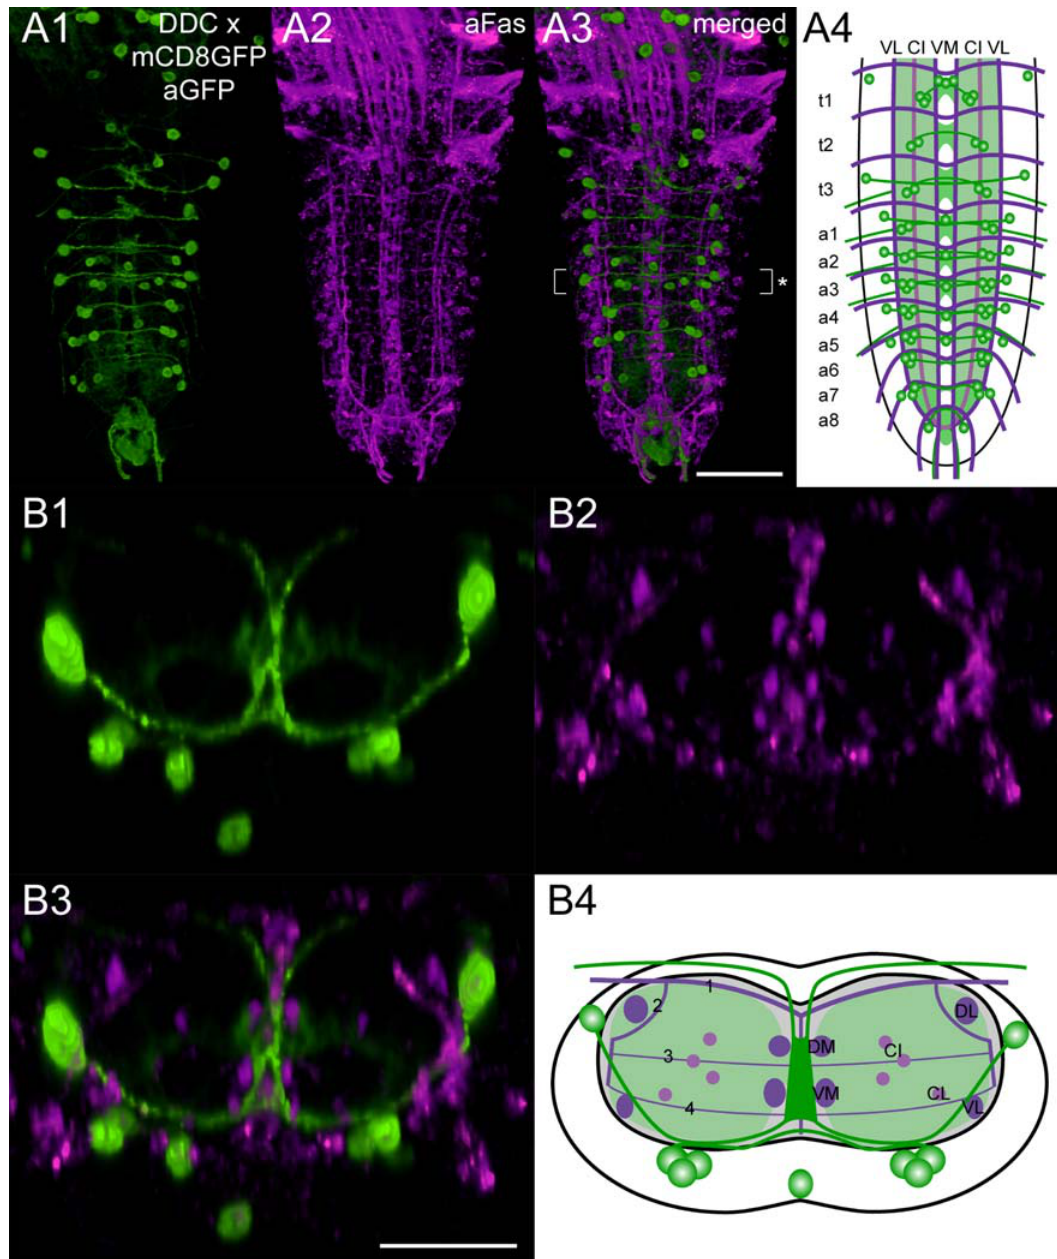
Figure 6. Mapping of Ddc-gal4 x mCD8GFP expressing neurons. A1) Ventral view of 3D image stacks showing volume-rendered GFP- immunoreactive neurons (green) and A2) Fas2-positive tracts (magenta) in a larva expressing Ddc-gal4 -driven mCD8GFP. The merged image (A3) served for an idealized schematic representation of Ddc-gal4 x mCD8GFP expressing neurons in the Fas2 landmark system (A4). B1-3) Corresponding transversal views of the neuromere a4 (* in A3), and B4) the deduced idealized scheme. Note that the Ddc-gal4 driver typically drives mCD8GFP expression in most, but not all presumed DDC neurons of the VG (see Fig. S3 and S4). Thus, some presumed DDC neurons are not included in the idealized schemes shown here. Green-shaded areas in the schemes contain a high concentration of GFP-immunoreactive arborizations. Scale bars: 50 m m in A), 25 m m in B) and C). doi:10.1371/journal.pone.0001848.g006 neurons (see above). The somata of the fourth and the fifth distinct neuron group (VL1 neurons; [19]; see also below) since they neither seem to synthesize 5-HT nor DA (Fig. S4). VL1 neurons DDC neuron groups reside dorso-laterally at the height of the DL tracts. The fourth group of DDC neurons showed strong DDC showed prominent Ddc-gal4 -driven mCD8GFP expression, but and TH immunolabeling. These DDC neurons, therefore, likely comparably weak DDC immunoreactivity (Fig. S3). The VL1 represent the presumptive dopaminergic dlTH neurons (Fig. S4; neuron somata are typically arranged as segmentally reiterated pairs in t3, a1-4, and a6-7, and reside laterally between the height see above), but were usually missing in the Ddc-gal4 expression pattern. The remaining neurons constitute the fifth distinct DDC of the VL and the DL tracts. In t3 and a1-4, VL1 neurites initially